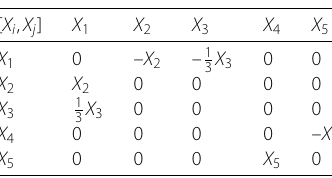
Table 1 Table of Lie brackets